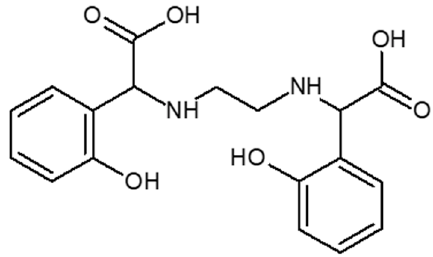
Figure 1. Structure of ethylenediamine- N , N (cid:48) -di[( ortho -hydroxyphenyl) acetic] ([ o , o ]